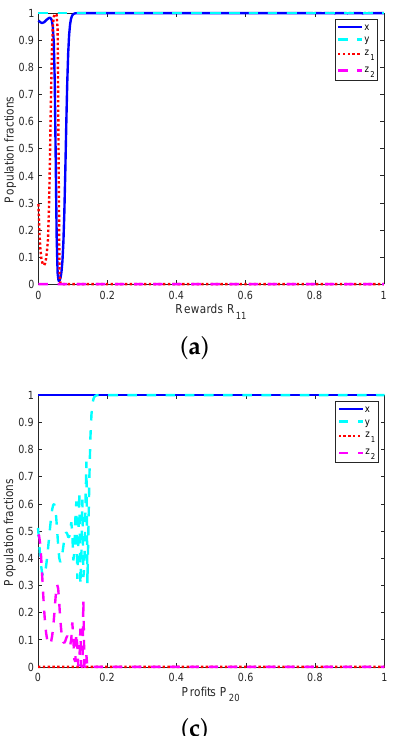
Figure 6. The impact of rewards for cybersecurity commitment on the ESS E 6 . ( a ) Evolution of population fractions x , y , z 1 , and z 2 over R 11 . ( b ) Evolution of population fractions x , y , z 1 , and z 2 over R 20 . ( c ) Evolution of population fractions x , y , z 1 , and z 2 over P 20 .